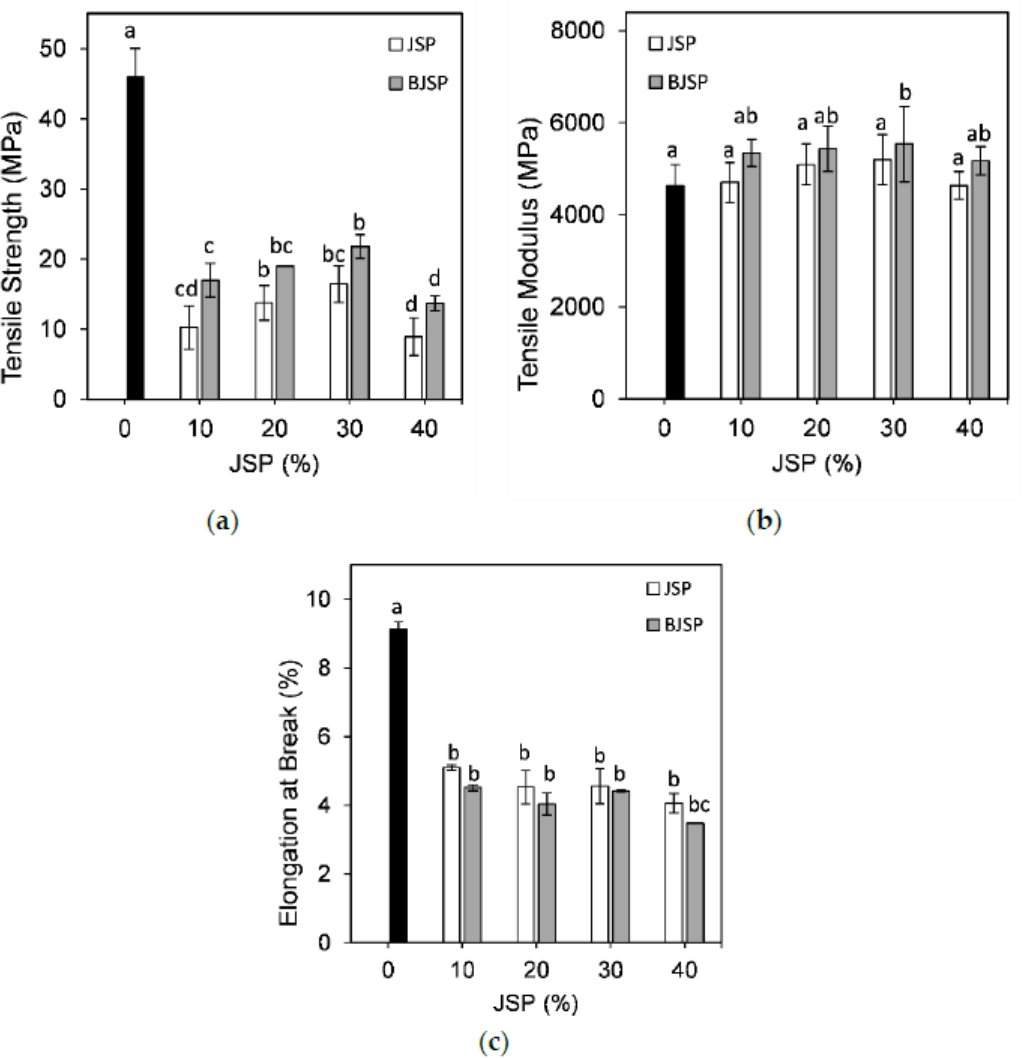
Figure 5. The figure shows the ( a ) tensile strength, ( b ) tensile modulus and ( c ) elongation at break of PLA and its composites. Data represents mean ± standard deviation of four independent